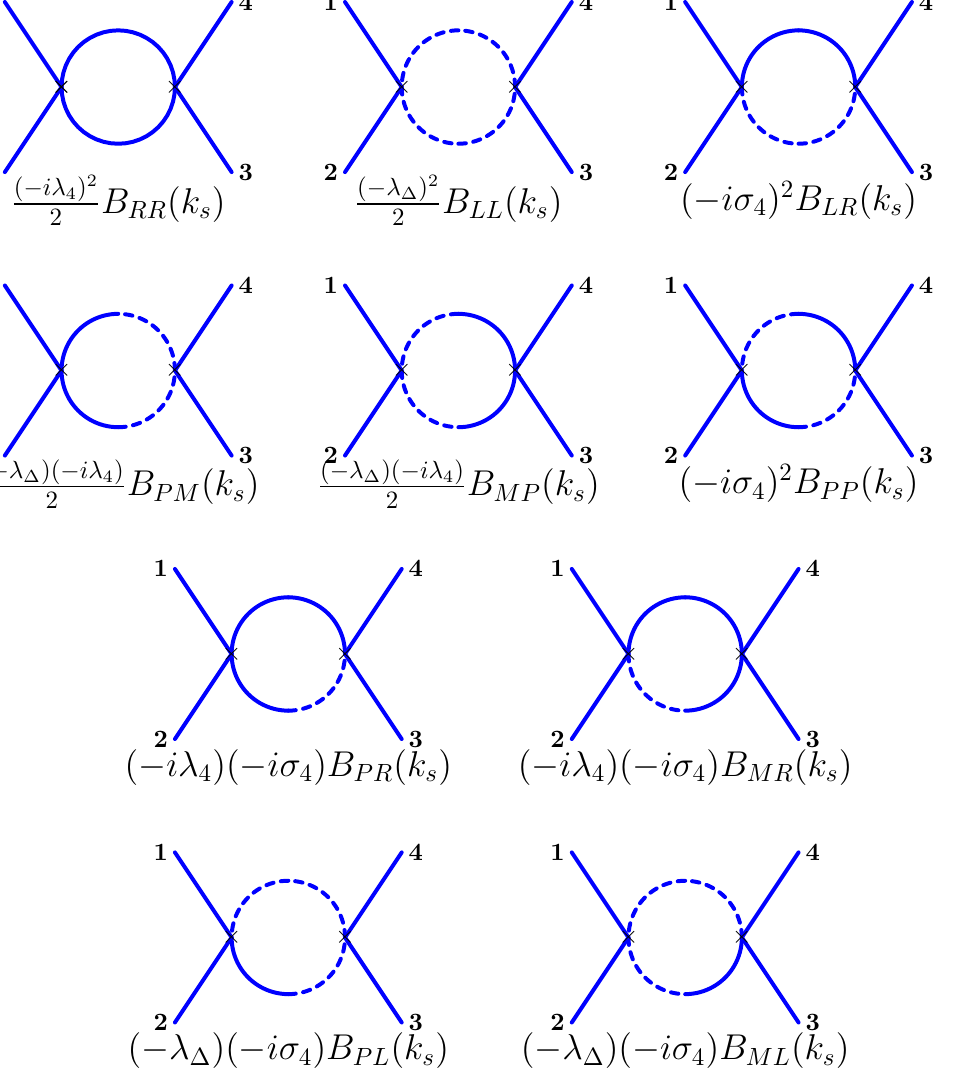
(cid:30) R (cid:30) R (Here k s = !